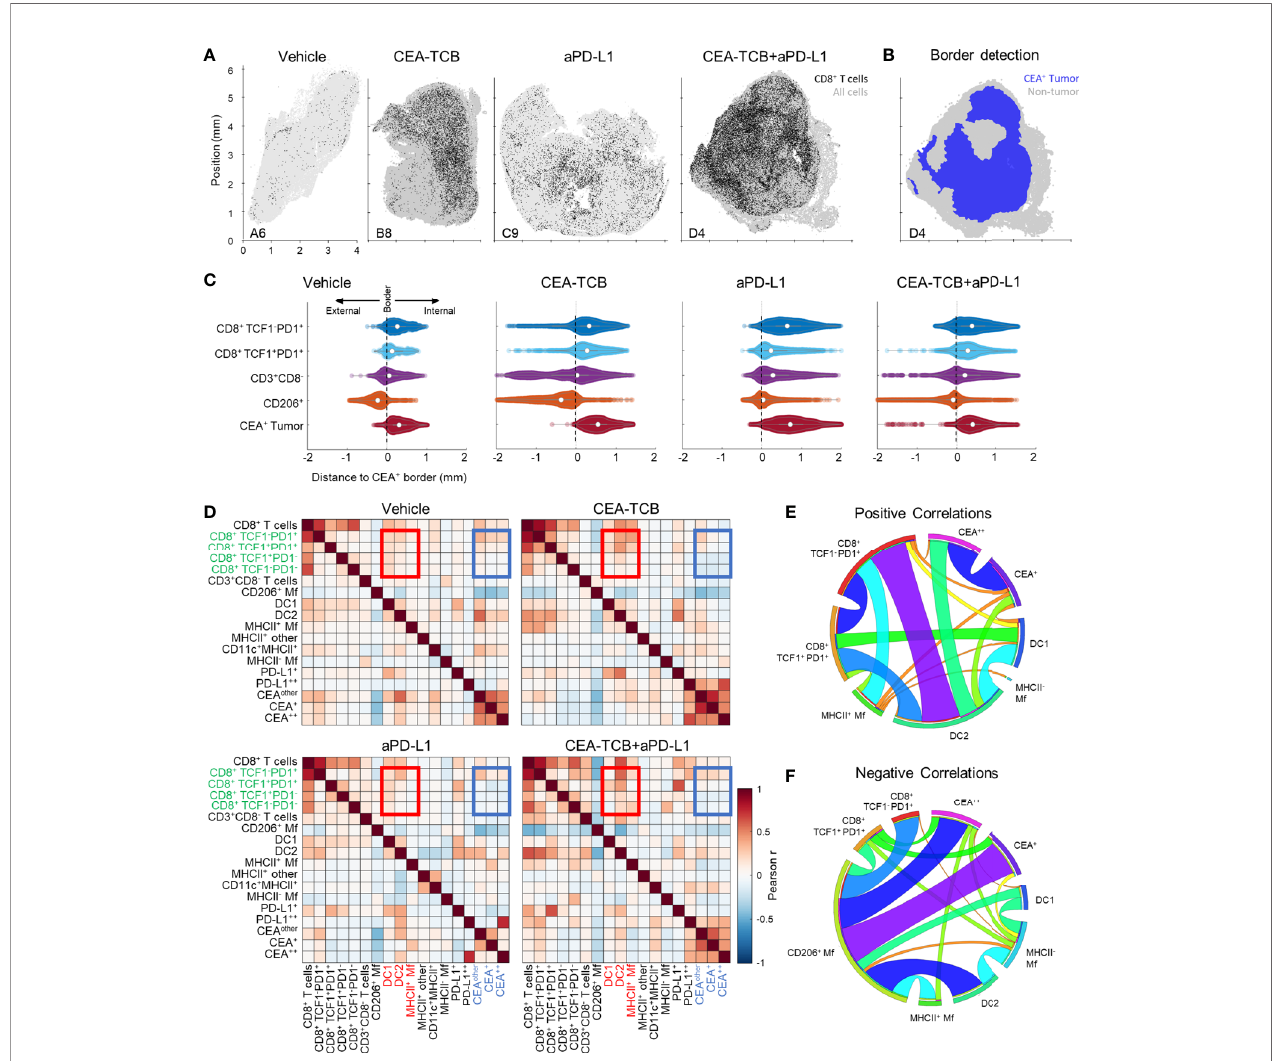
FIGURE 2 | Histocytometry and CytoMAP based quanti fi cation of the MC38-CEA tumor microenvironment. (A) Positional plots of CD8 T cells (black) overlaid over all imported cell objects (gray) in the indicated tumor samples. (B) CEA + tumor regions were identi fi ed using CEA spot clustering and visualized (blue), with additional overlay of all other objects (grey). (C) The distances of select cell populations to the border of the CEA + tumor region is shown in panel (B) from combined samples of each treatment group. Negative distances correspond to positions outside the border of the tumor region and positive distances correspond to positions inside the tumor region. (D) Heatmaps displaying the Pearson ’ s correlation between number of cells per neighborhood for each cell population pair for each treatment group. (E) Circos plots of the scaled and rounded positive Pearson correlation between number of cells per neighborhood across all samples for the indicated cell types. Plots were generated using (www.circos.ca). (F) Circos plots of the scaled and rounded negative Pearson correlation between the number of cells per neighborhood across all samples for the indicated cell types. Colors were auto-generated. All the above plots were generated as described in Figure S1A ; n=2 for control, n=3 for CEA-TCB and aPDL1 and n=4 for CEA-TCB+aPD-L1